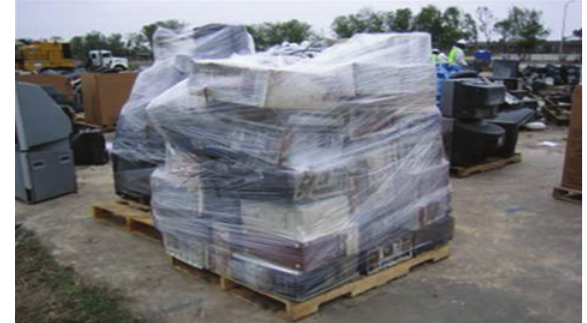
Figure 9: White goods were compressed, baled, and shipped to recycling facilities. Picture provided courtesy of USACE.